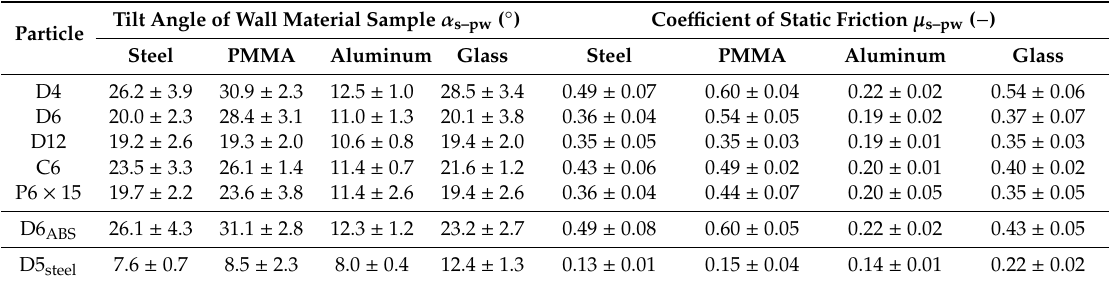
Table 8. Results of particle-wall static friction coe ffi cients